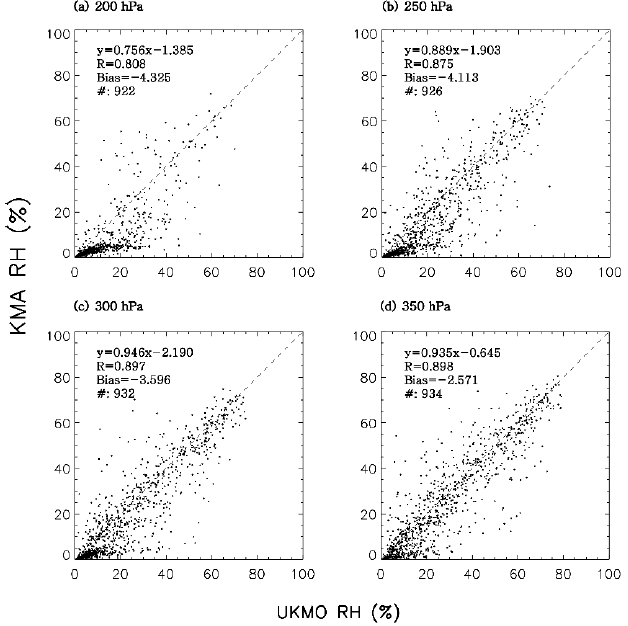
Figure 3. Scatter plots of the relative humidity from the Korea Meteorological Administration model (UM-KMA) versus the United Kingdom Met Office model (UM-UKMO) for ( a ) 200, ( b ) 250, ( c ) 300, and ( d ) 350 hPa in January–May. The dashed lines represent the perfect matches.